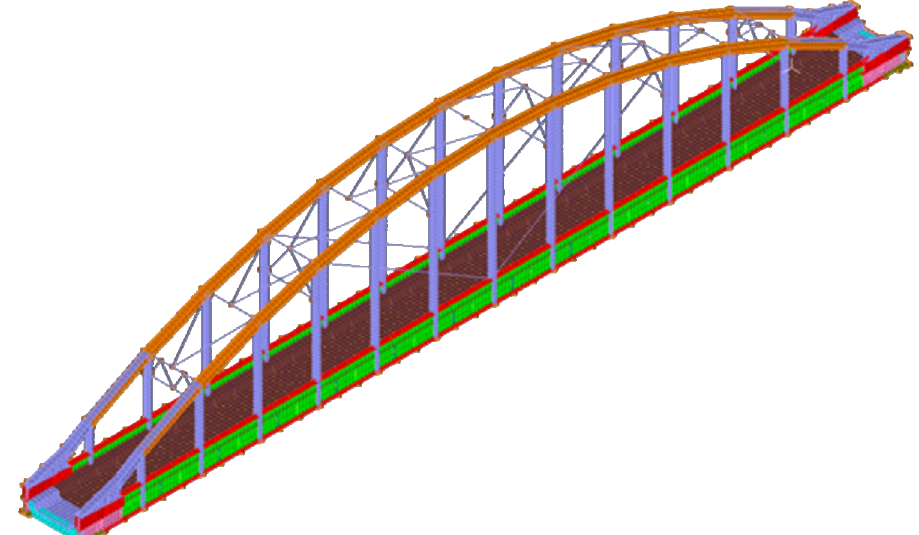
Figure 5. Finite element method (FEM) model in ADINA with the shell finite elements applied to most parts.